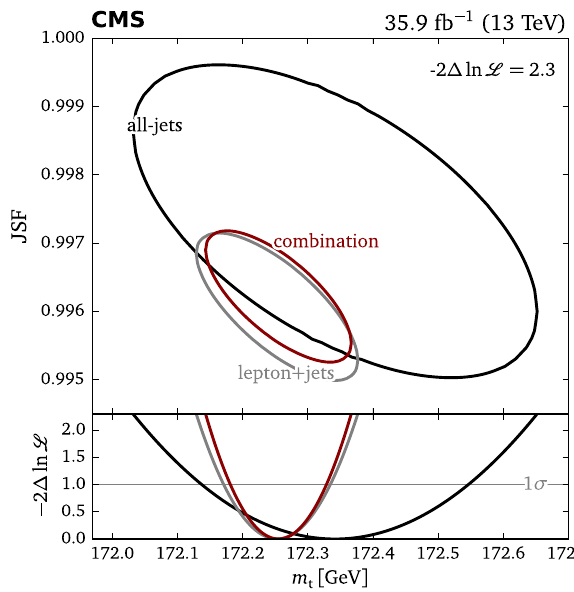
Fig. 4 Difference between extracted and generated top quark masses (upperpanel)andJSFs(lowerpanel)fordifferentinputmassesandJSFs after the single-channel calibrations for the combined measurement. The values are extracted using the 2D method [17]. The complete list of uncertainties is shown in Table 2.